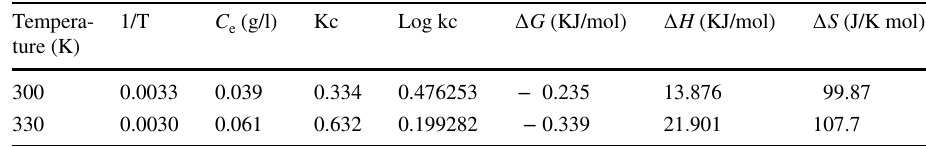
Table 4 Thermodynamic parameters